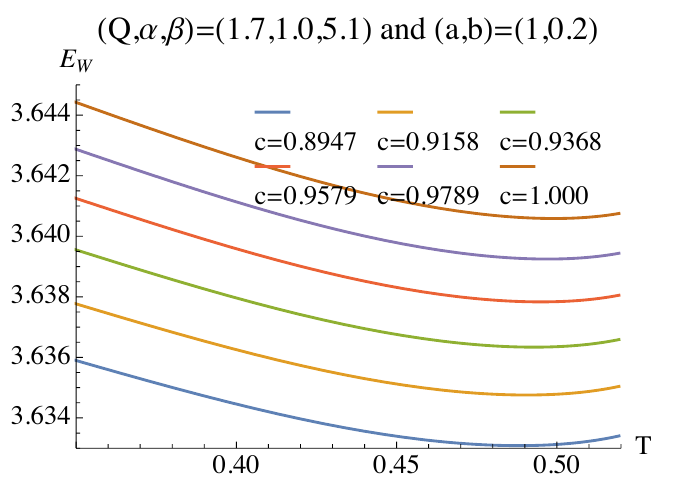
Figure 14 . The temperature vs. EWCS at the case where no thermal phase transition